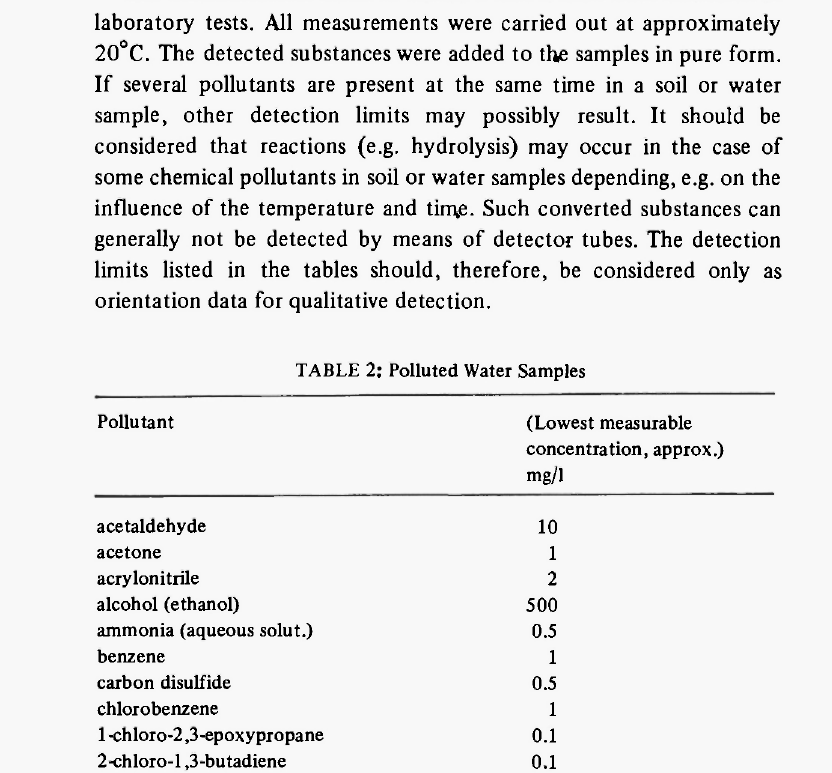
TABLE 2: Polluted Water